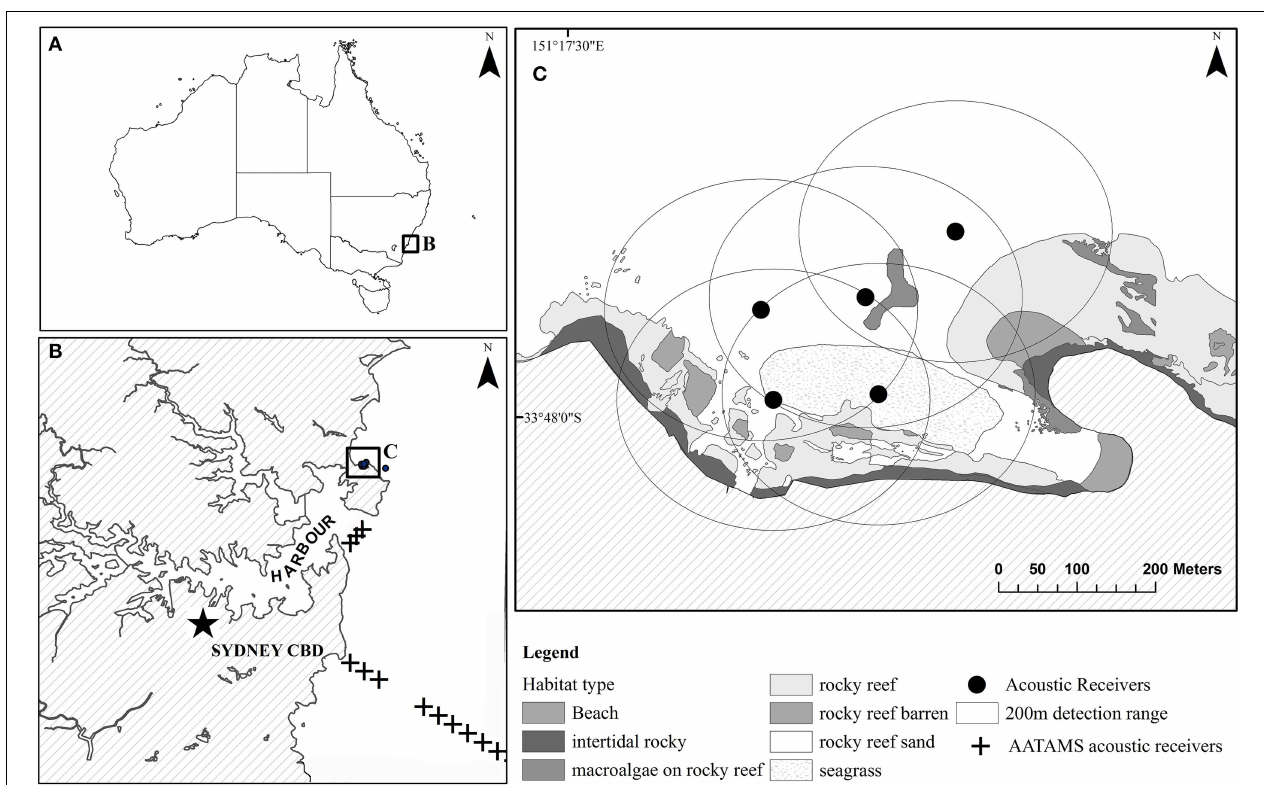
FIGURE 1 | (A) Map of Cabbage Tree Bay Aquatic Reserve (CTBAR). Panel (B) shows CTBAR in relation to Sydney harbour and the AATAMS acoustic receivers wobbegongs were detected on. Panel (C) shows a close-up of the acoustic receivers at CTBAR and their detection